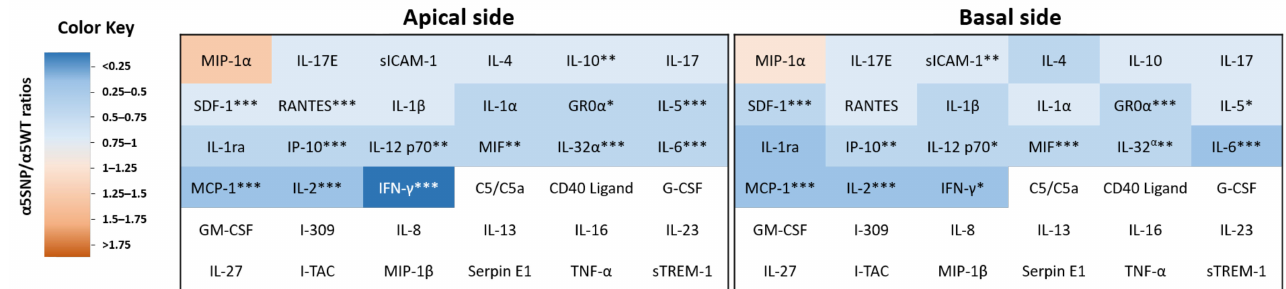
Figure 3. Cytokine and chemokine expression in AEC culture supernatants. Heat map colours correspond to the α 5SNP/ α 5WT cytokine and chemokine ratios at ALI-7 from apical ( left ) and basal ( right ) supernatants obtained from AEC cultures ( n = 4 α 5WT and n = 9 α 5SNP). Downregulated (blue) and upregulated (orange) proteins in supernatants from α 5SNP-expressing cells are represented. Non-detected proteins are represented in white. * p < 0.05; ** p < 0.01; *** p < 0.001 α 5WT vs. α